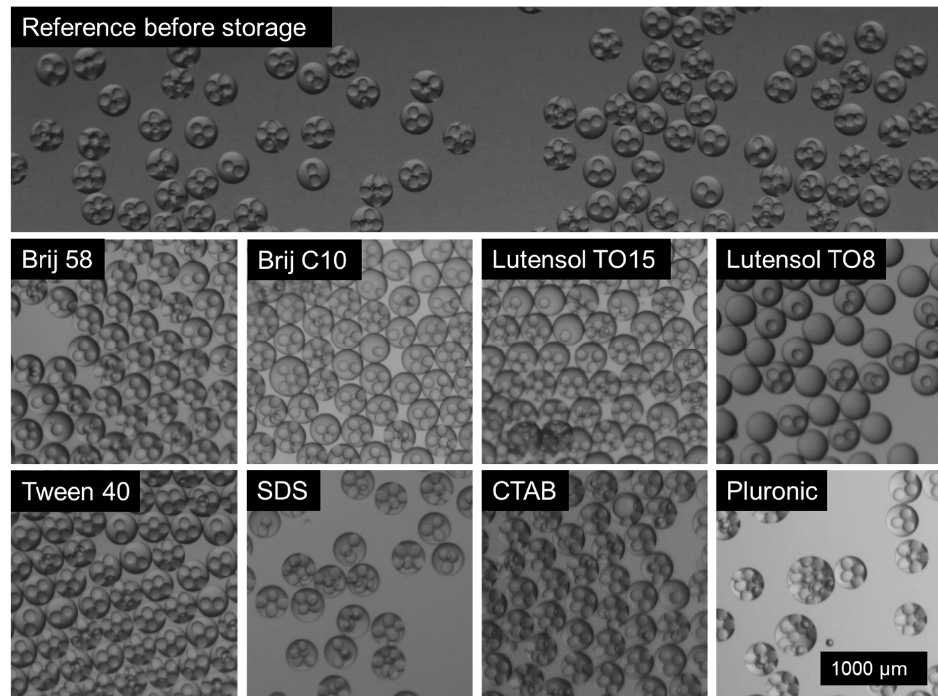
Figure 3. Photos of double emulsion droplets less than 30 s after microfluidic break-up ( top ) and after 20 min of storage in their respective surfactant solutions ( second and third row ). W 1 droplets were stabilized with PGPR for all samples. Droplets stabilized with Brij 58, Lutensol TO15, Tween 40 and SDS show near to no change. Emulsions with Brij C10 and Pluronic show O–O coalescence, with CTAB droplets show W 1 –W 1 coalescence and with Lutensol TO8 release of inner droplets via W 1 –W 2 coalescence occurs. The scale bar on the bottom right applies to all subfigures.